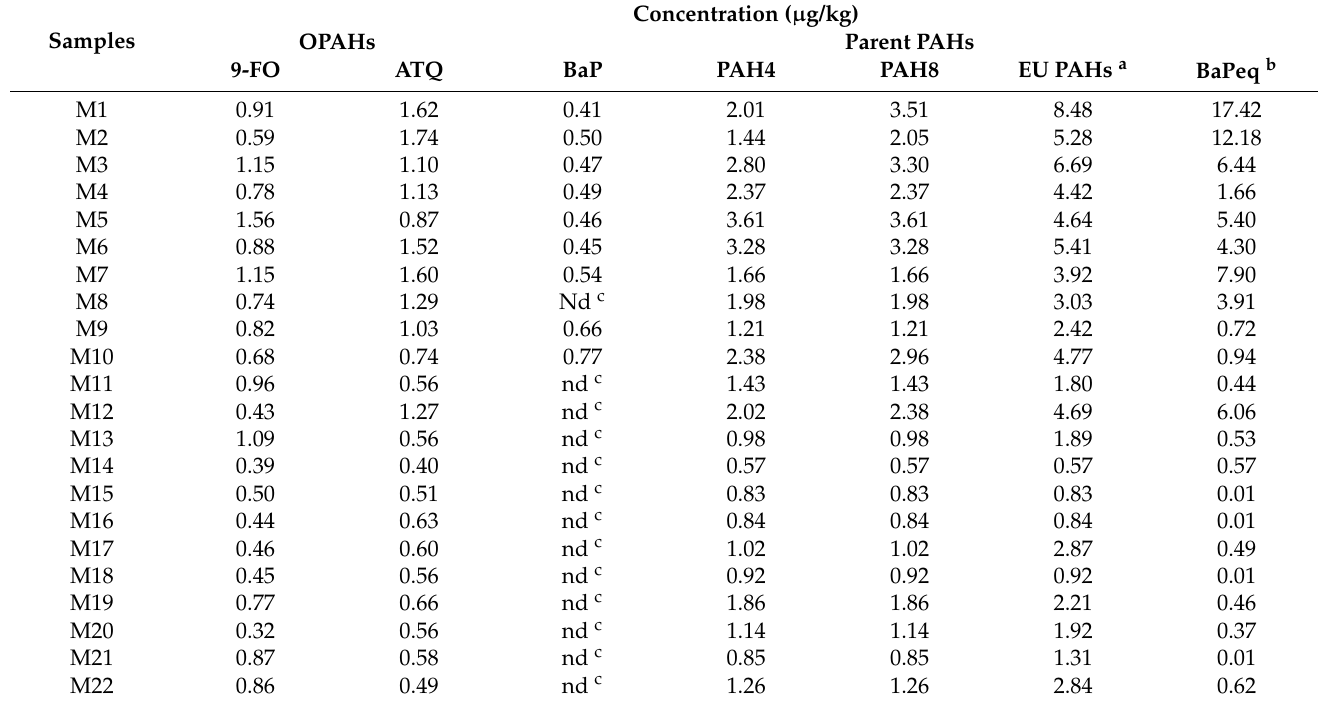
Table 3. OPAH and PAH concentrations of 22 commercial milk samples by UPCC-